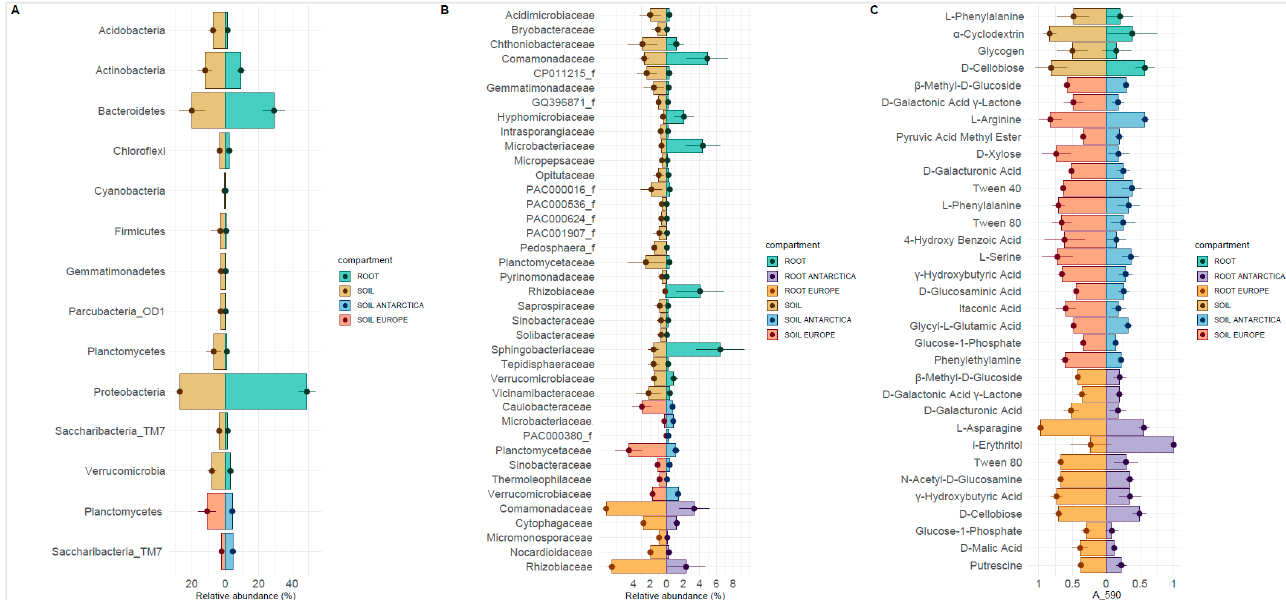
Figure 7. Statistically significant differences ( p < 0.05) between different groups (see legends) of Poa annua root-associated communities: ( A )—sequence contribution identified on a phylum taxonomic level; ( B )—sequence contribution identified on a family-rank taxonomic level; ( C )—community responses on Biolog Ecoplates based on absorbance values at 590 nm (A_590).